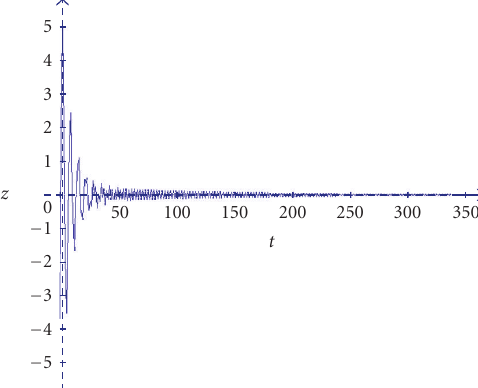
Figure 6.20 . Bounded solution of (5.2) in the point V (1000,24 . 16), a 0 = 4.